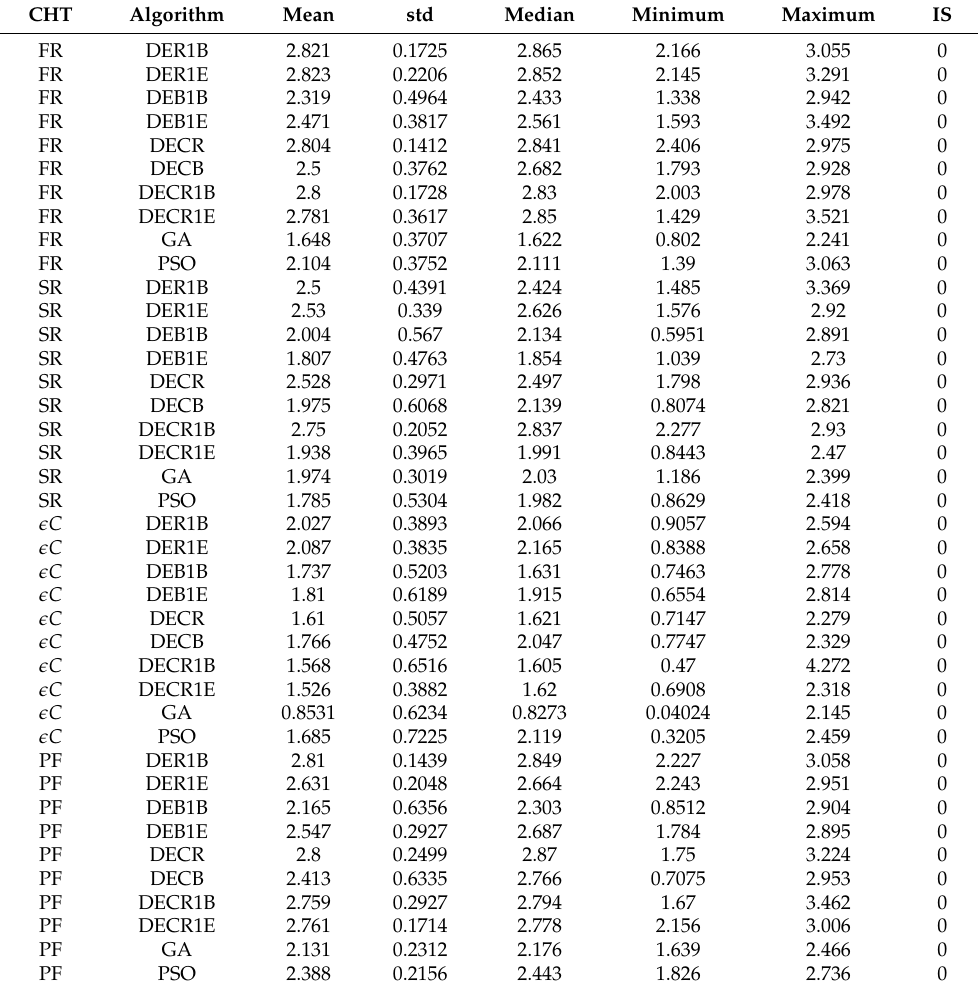
Table A22. PR descriptive statistics for study case 2: Cam-linkage mechanism. IS means the number of infeasible solutions through the